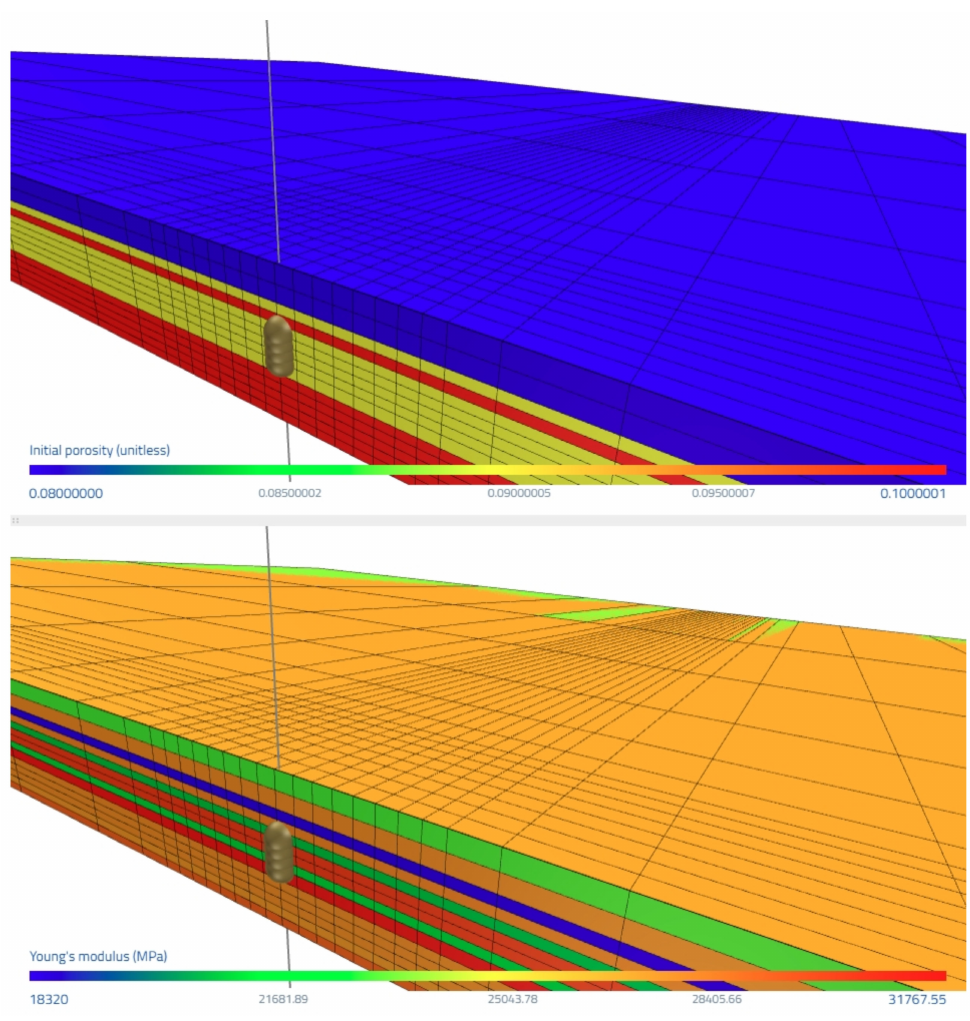
Figure 2. Cross-section of matrix mesh configuration used in the 12 km × 12 km ResFrac™ model domain for the Upper Mannville Formation, showing mesh refinement surrounding the injector wellbore. Wellbore and perforations are indicated by a grey vertical line and cylinder in the center of the model and stratigraphic sequence. Note: not to scale—vertical exaggeration applied for visualization